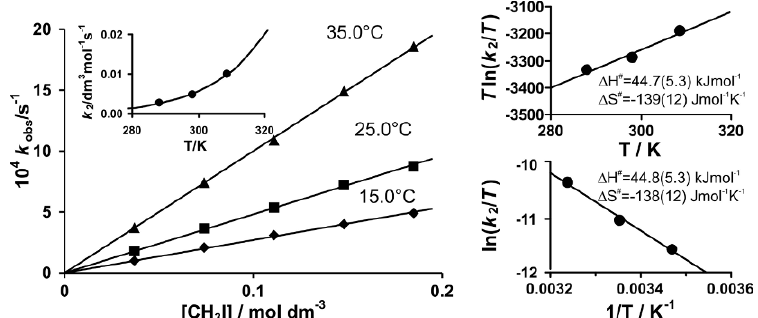
Figure 3. Temperature and iodomethane concentration dependence for observed pseudofirst-order rate constants k of iodomethane to [Rh(PhCOCHCOPh)(CO)(P(OCH according to Eq. 2. Right: Eyring plots according to Eqs. 3 and 4.